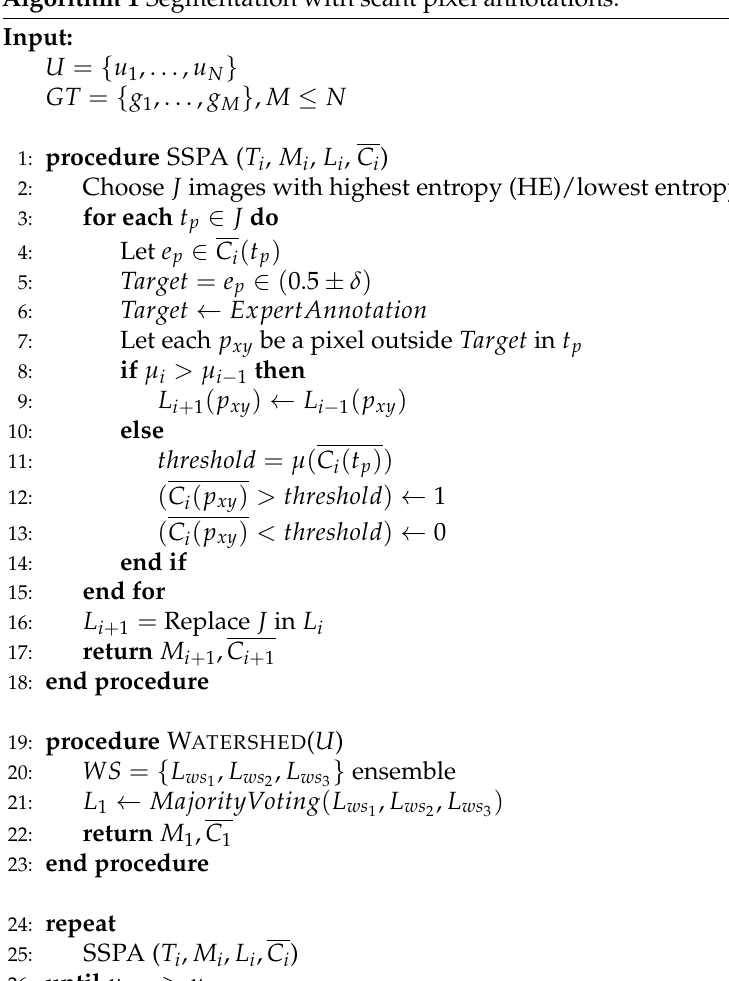
Algorithm 1 Segmentation with scant pixel